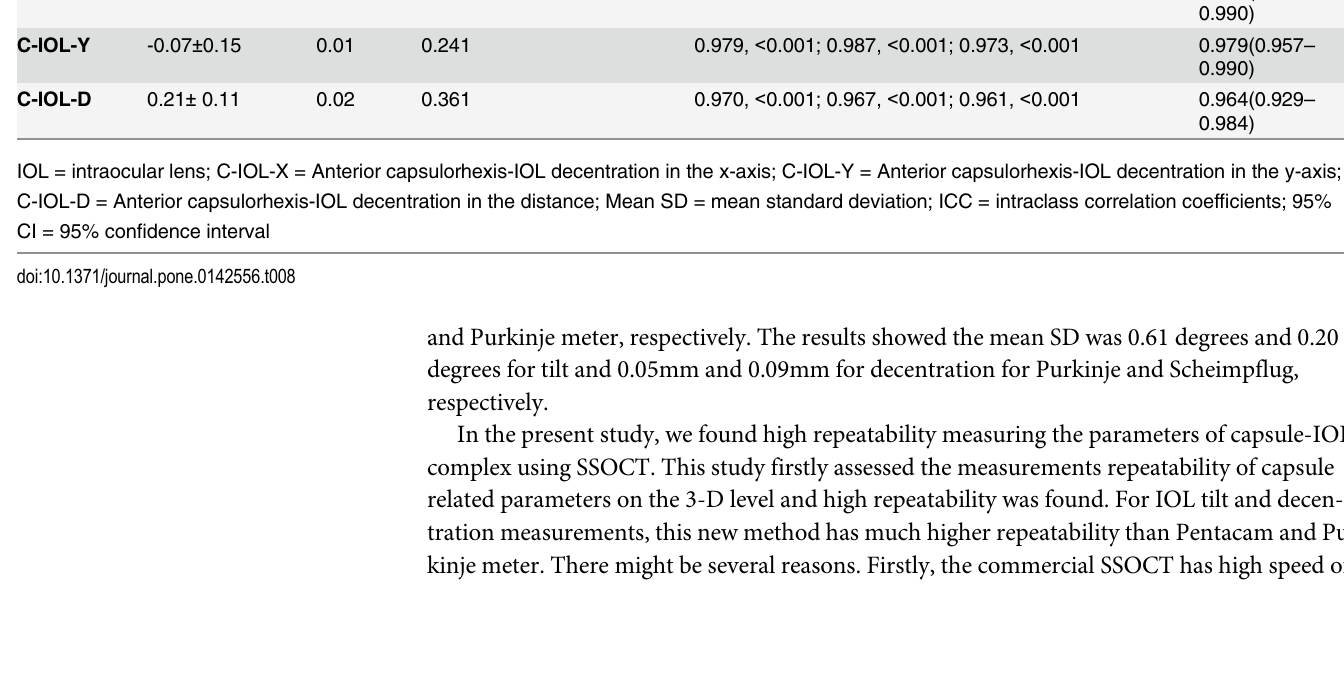
Table 8. The repeatability results of C-IOL-X, C-IOL-Y, C-IOL-D using different statistical analysis methods. Parameters Mean ± SD Mean Repeated measurement Pearson correlation between every two indexes (r, (mm) SD (P) P)